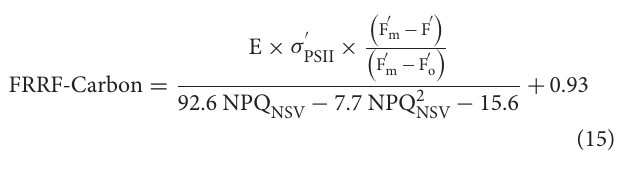
reliability in other oceans. Therefore, more data are needed to further enhance the applicability of FRRF-based field model to other